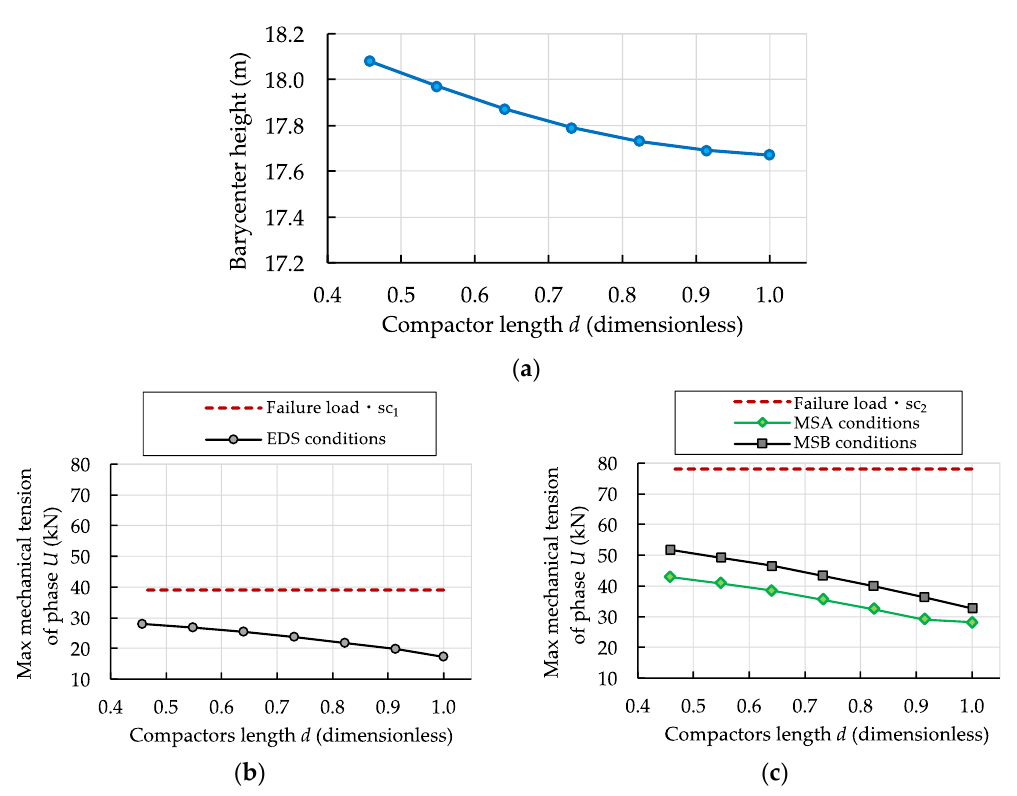
Figure 9. Influence of compactors dimension (where d = 1 means compactors absence) on mechanical results. ( a ) Line barycenter height; ( b ) Maximum mechanical stress applied to phase U (which results the most stressed conductor) in EDS conditions, compared to the wire breaking tension weighted by the security coefficient sc 1 ; ( c ) Maximum mechanical stress applied to phase U in MSA and MSB conditions, compared to the wire breaking tension weighted by the security coefficient sc 2 .